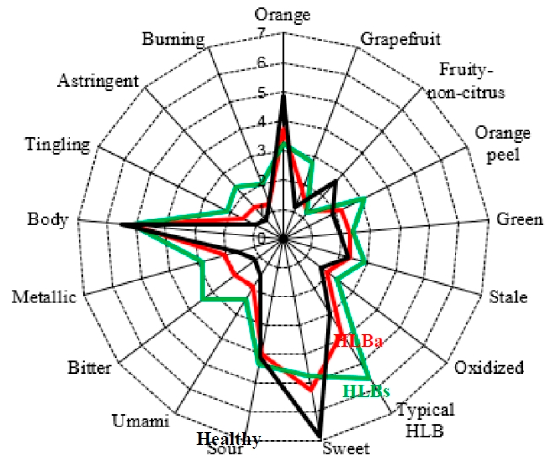
Figure 7. Trained descriptive sensory analysis of fruit from healthy (Healthy) or HLB affected trees were separated into those that were symptomatic (HLBs) or asymptomatic (HLBa) for the disease prior to juicing (HLB = Huanglongbing disease).